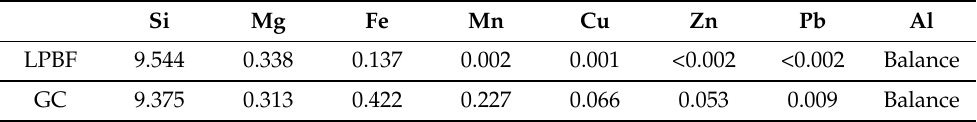
Table 1. Mean chemical composition (wt%) of AlSi10Mg produced by Laser-based Powder Bed Fusion (LPBF) and Gravity Casting (GC).